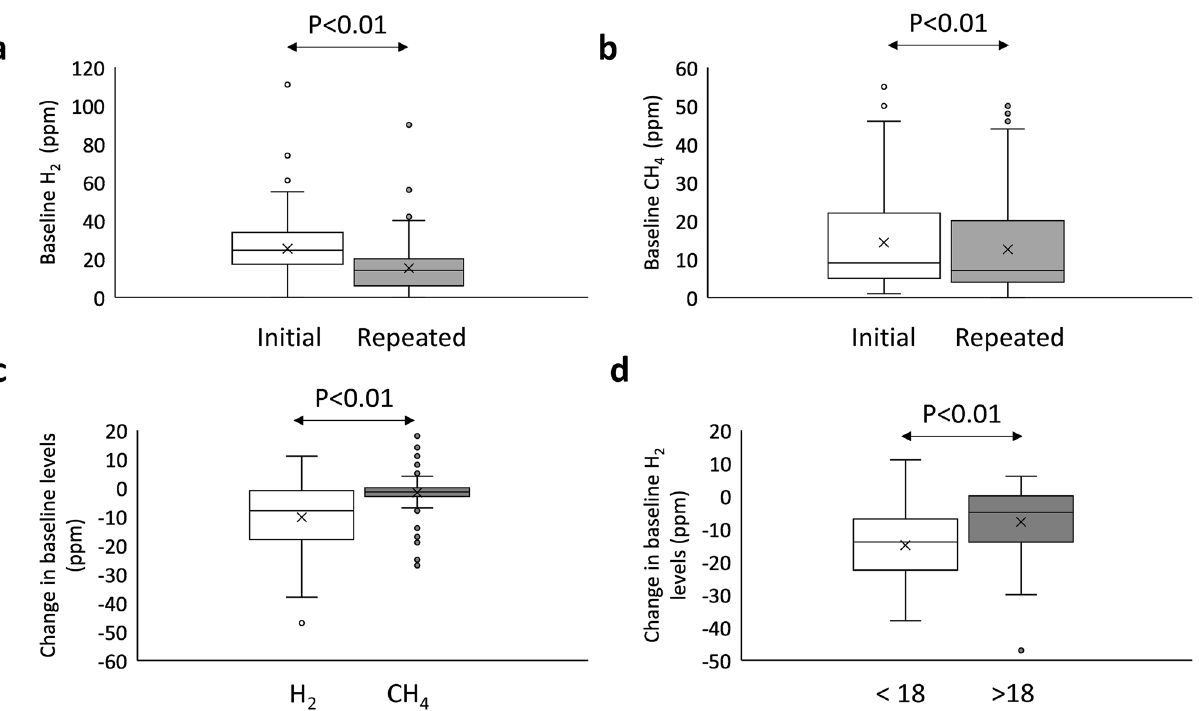
Figure 3. Initial and repeated baseline levels of H 2 ( a ) and CH 4 ( b ). ( c ) Range of change in H 2 and CH 4 levels between initial and repeated baseline samples. ( d ) Range of change in H 2 levels according to patients’ age. Baseline levels are represented in Box-Whisker